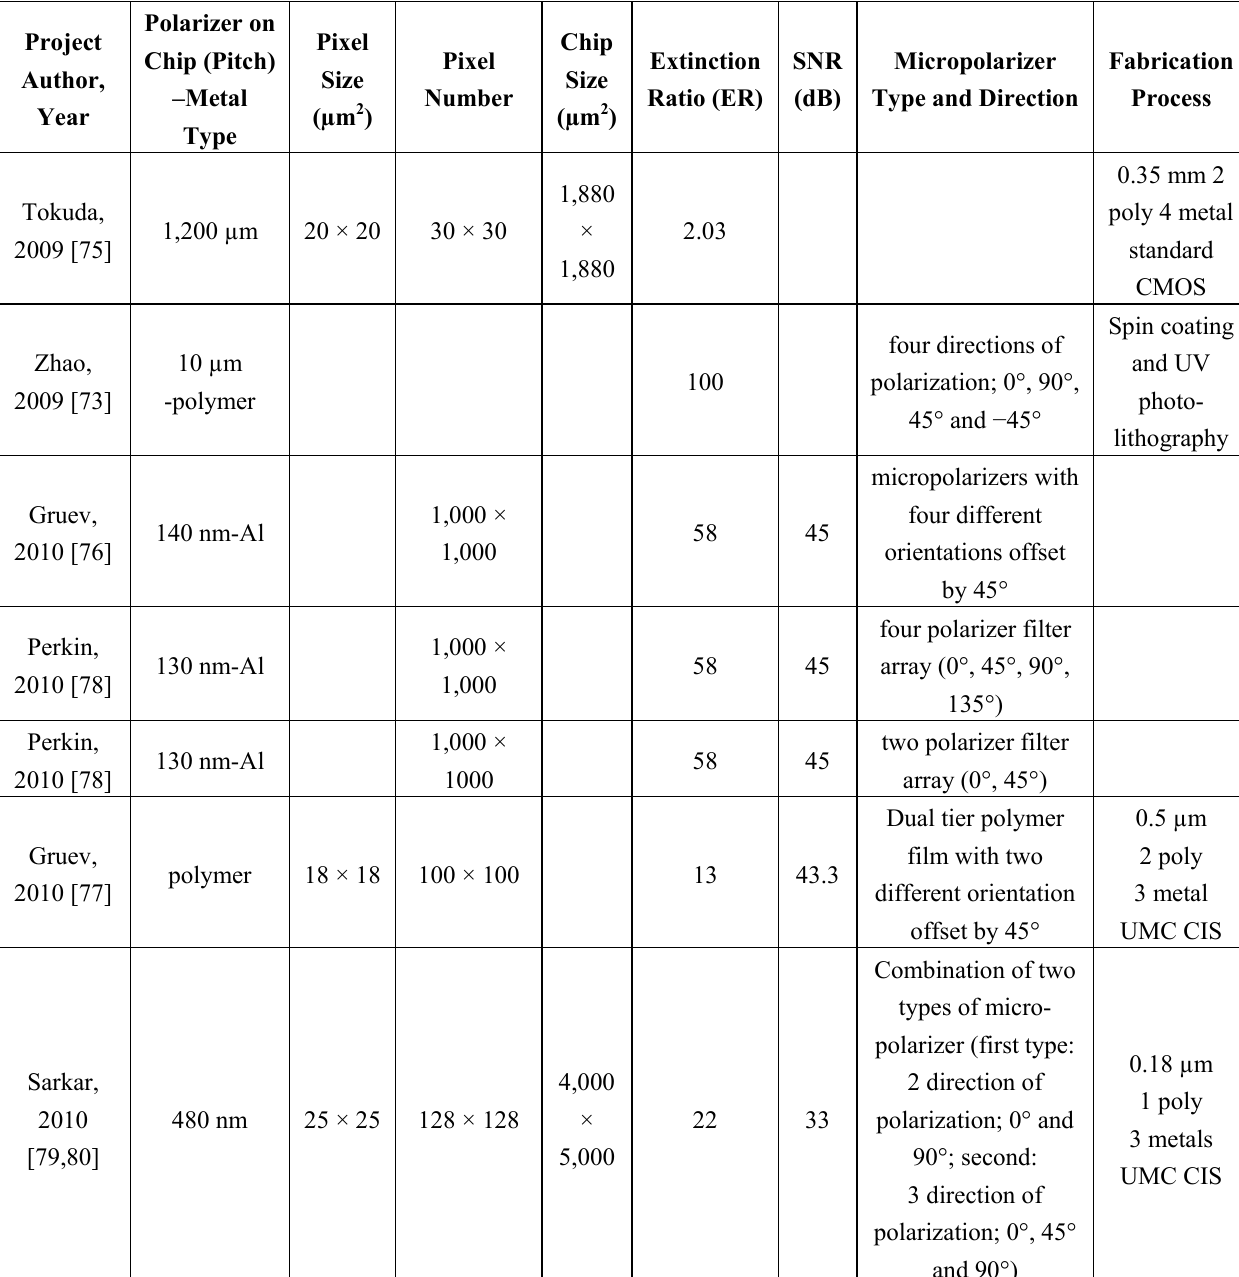
Table 2. Development progress of CMOS polarization